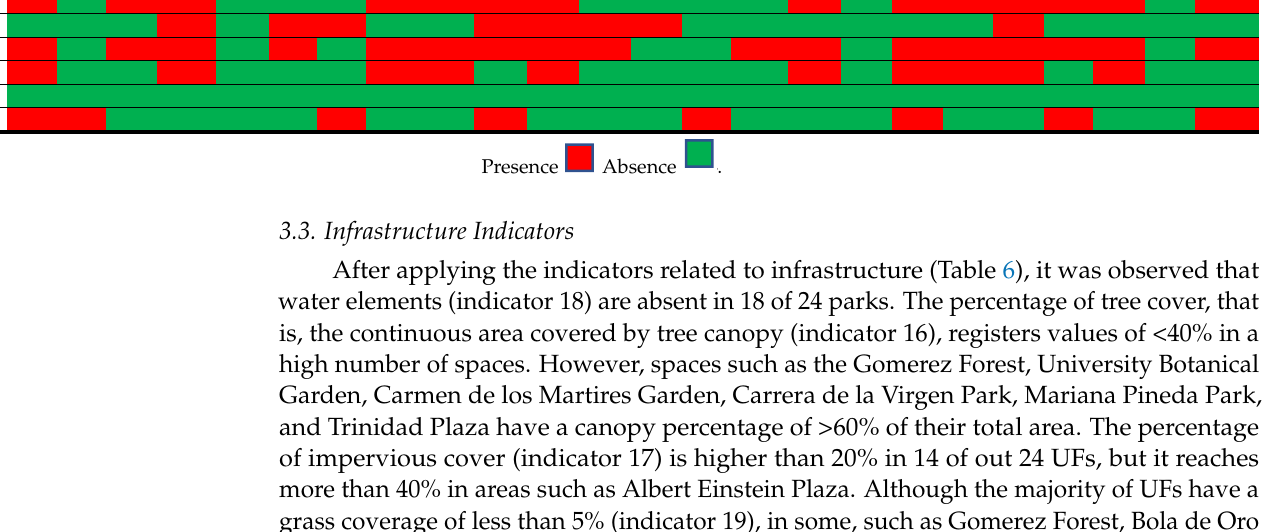
Table 6. Results obtained for the Infrastructure indicators of the different UFs. IND AE AP BG BG U BO CC CL CM CV FN FS GA GL PC PC O PM PS PT PV QA SF TG TM TM O 16 17 18 19 20 Low